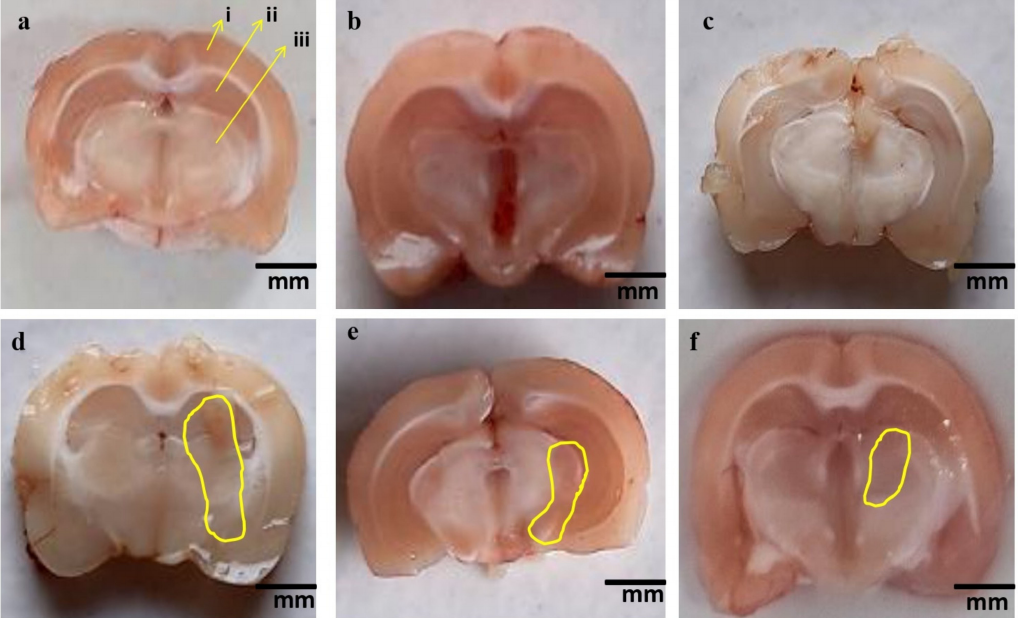
Figure 16. The effect of 4-hydroxyisoleucine on gross pathological changes (brain sections) in rats following methyl mercury exposure. ( a ) Normal control [i. Cerebral cortex, ii. Hippocampus, iii. Basal ganglia] ( b ) Vehicle control. ( c ) 4-HI100 perse . ( d ) MeHg5. ( e ) MeHg5 + 4-HI50. ( f ) MeHg5 + 4-HI100. Note: Yellow circles point to the demyelinated area; (Scale bar:5 mm) .